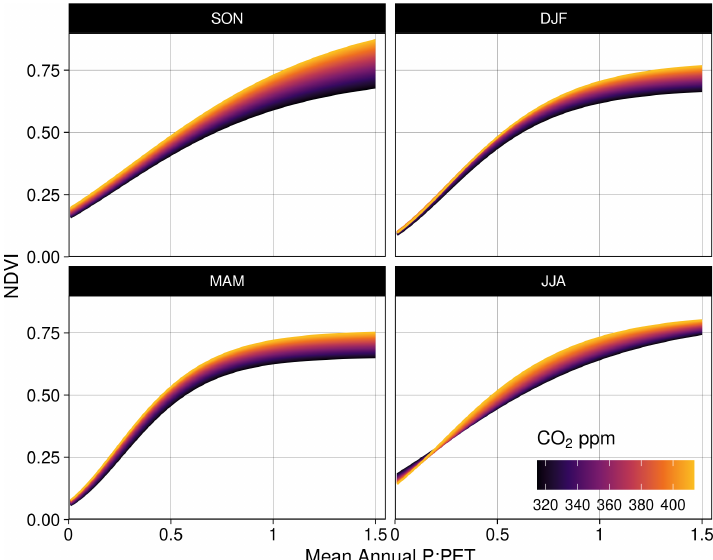
Figure A6. Seasonal NDVI as a Richards growth function with linear modifiers of CO 2 and the anomaly of P :PET (Eq. 6).